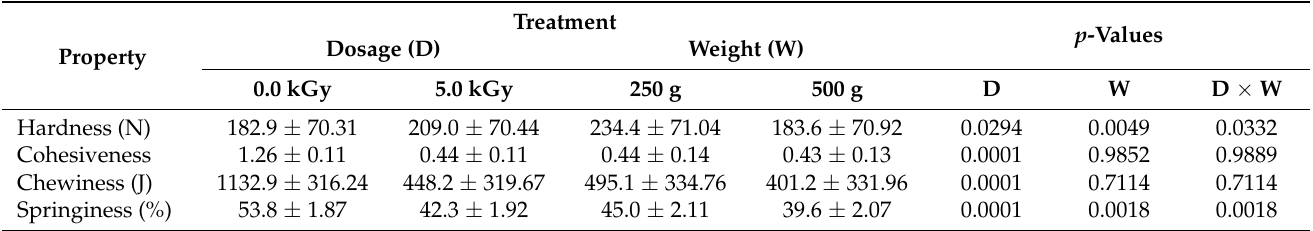
Table 3. Effects of the irradiation treatment (0.0 kGy and 5.0 kGy) and sample size (500 g and 250 g)